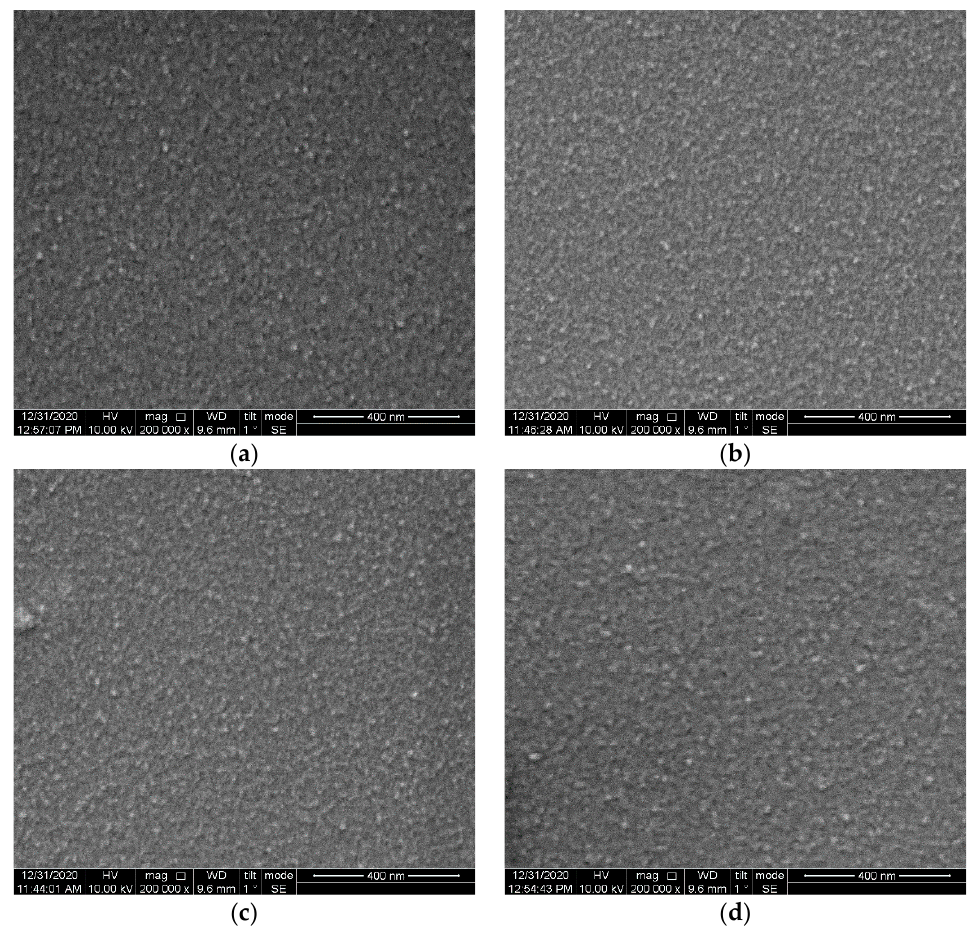
Figure 7. SEM micrographs of CoFe 40 BY 40 nm. ( a ) RT, ( b ) after annealing at 100 °C, ( c ) after annealing at 200 °C, ( d ) after annealing at 300 °C.